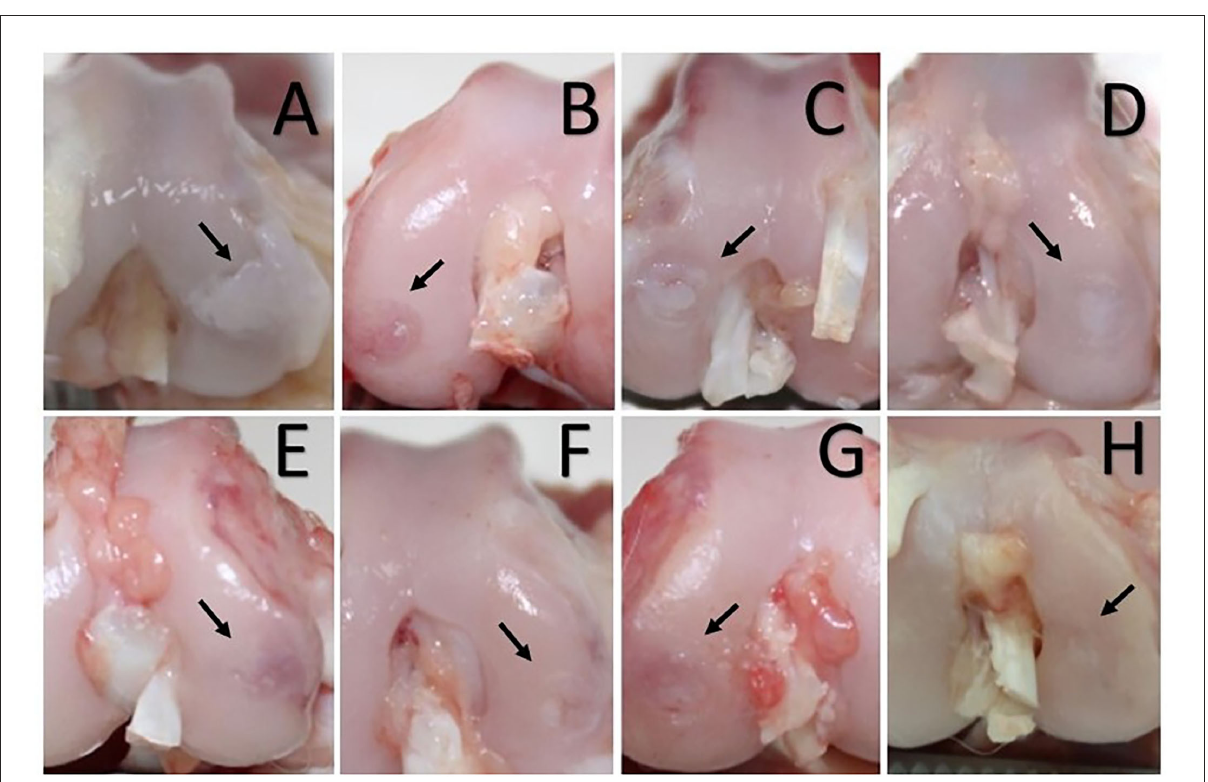
FIGURE5 Chondral defect assessment 56 (A–D) and 84 days (E–H) after the intraosseous infiltration. (A, E) Control group. (B, F) Platelet rich in growth factors group treated condyles. (C, G) Adipose mesenchymal stem cells treated condyles. (D, H) Condyles treated with the combination of plasma rich in growth factors and adipose mesenchymal stem cells. (A) White and hypertrophic repair tissue with cracks and fibrillations in the adjacent cartilage. (E) Translucent, and fibrillated tissue with diffuse osteoarthritic changes in the adjacent articular cartilage. (B, C) Predominantly translucent and smooth repair tissue. More than 50% of the defect’s depth filled in, and blood vessels are present in more than 50% of the repaired tissue. (F, G) Predominantly white and smooth repaired tissue; the defect is almost level with the adjacent cartilage. Some cracks are present in the adjacent articular cartilage. (D) Predominantly white, smooth, and homogeneous repair tissue; the defect is level with the adjacent articular cartilage, which looks normal. (H) Hyaline, smooth, and homogeneous repair tissue. The defect is filled and level